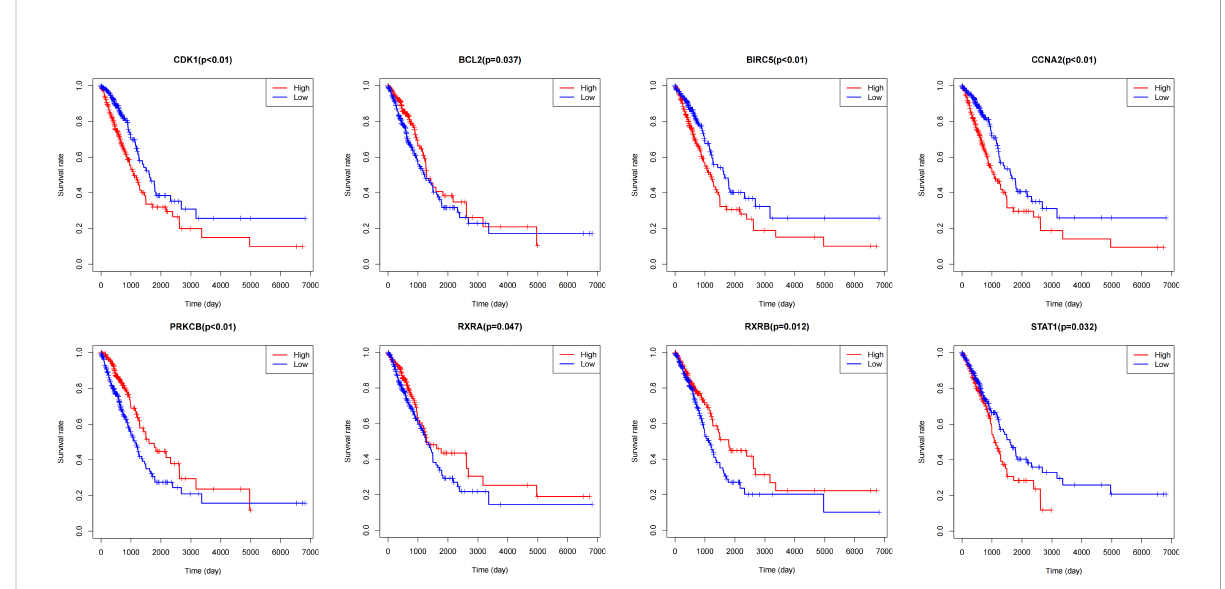
FIGURE 9 Survival curves of BCL2, BIRC5, CCNA2, CDK1, PRKCB, RXRA, RXRB, and STAT1 in lung adenocarcinoma patients.